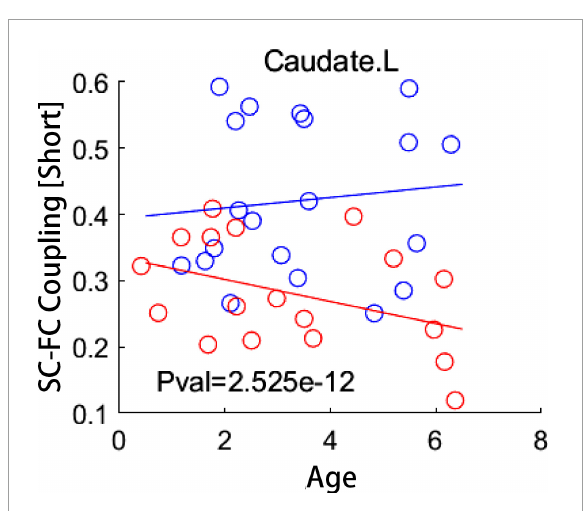
FIGURE4 Group-age interaction of coupling score examined by a linear mixed effect model. Compared to healthy subjects, patients with infantile esotropia showed distinct developmental trajectory of local coupling measures in left caudate nucleus (FDR-corrected P < 0.05). Blue circles indicate healthy controls while red circles represent patients with infantile esotropia. SC, structural connectivity; FC, functional connectivity; L,